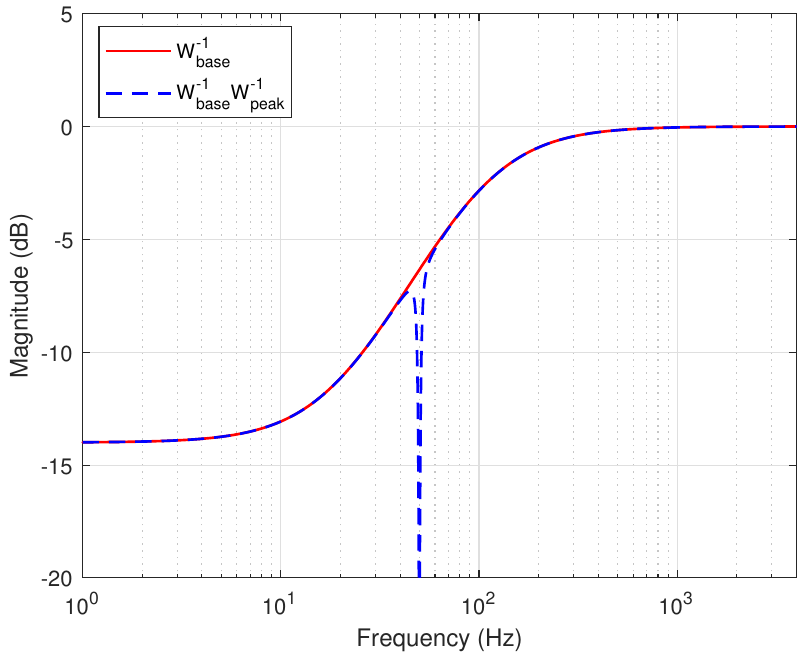
Figure 3. Weight functions to reject wide and narrow band